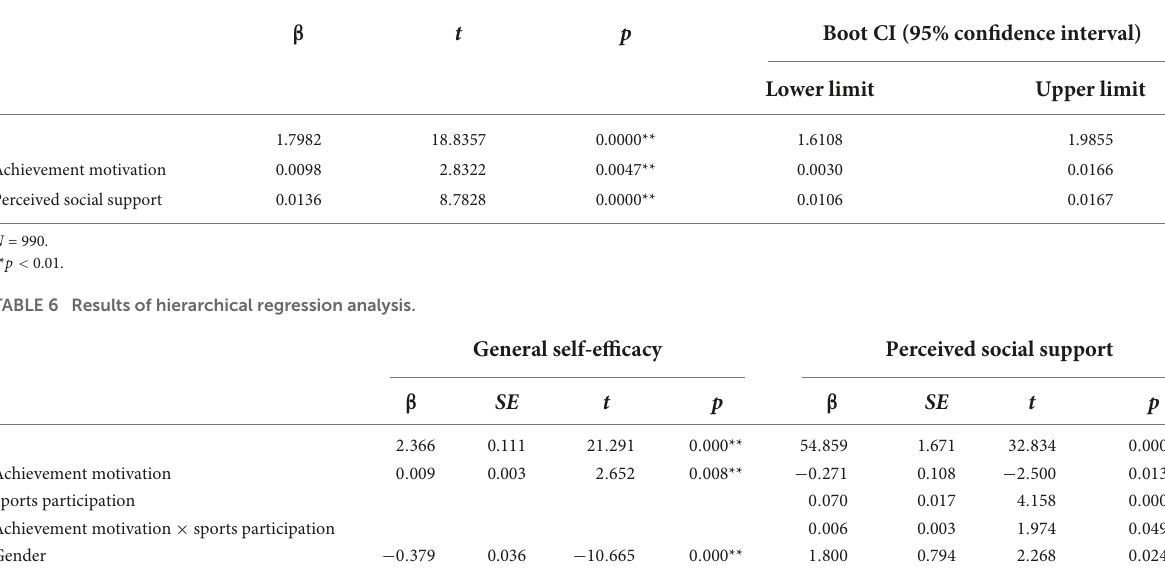
TABLE 5 Mediation model effect.